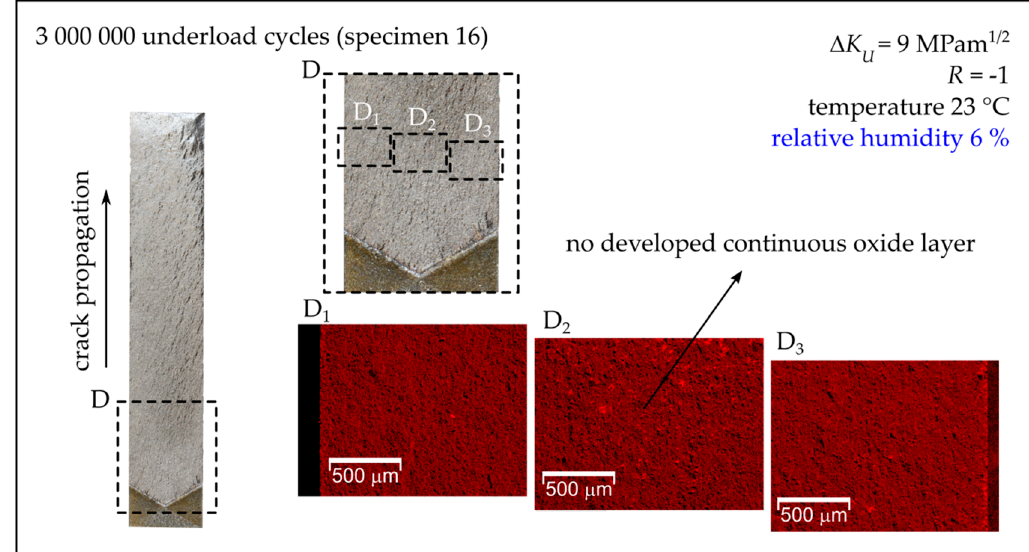
Figure 14. Fracture surfaces of Specimens 16 tested in 6% relative humidity air (see also Table 3). On the left-hand side, the fracture surface of one quarter of the MT specimen with a detail is shown. The right-hand side shows the EDS maps of the distribution of oxide particles.